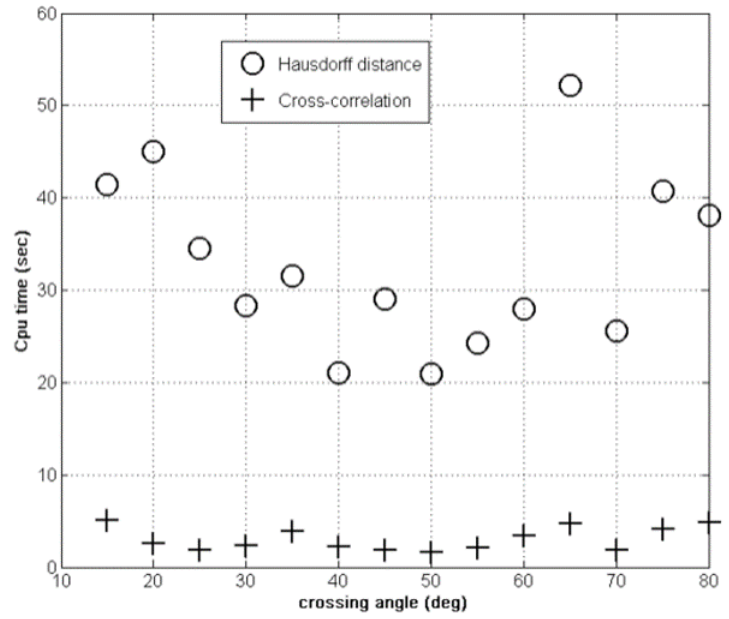
Figure 7. CPU cost: Hausdorff vs. cross correlation fitness.